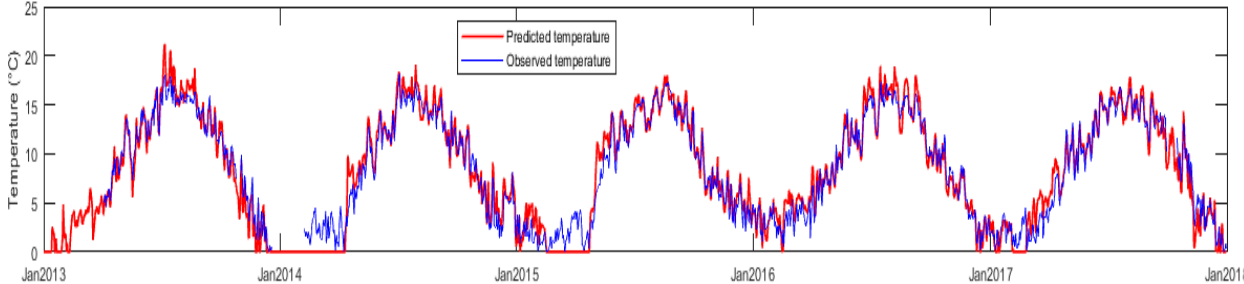
Figure 6. Observed and simulated water temperature at the temperature gauging station for years 2013–2018. Table 2. Performance criteria for the simulated water temperature using a 5-fold cross-validation method and performance criteria using the average of the parameters obtained for the cross-valida- tion calibration samples.